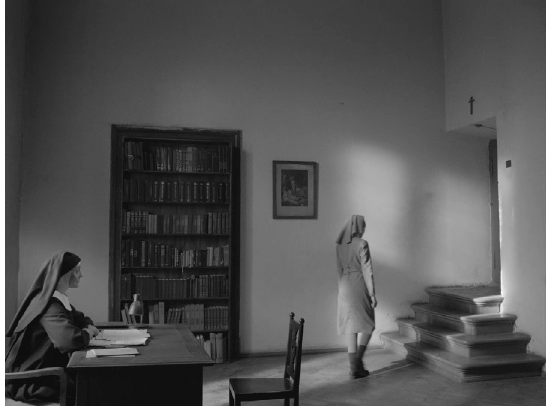
Figure 9. Ida blends in with the walls of the convent.